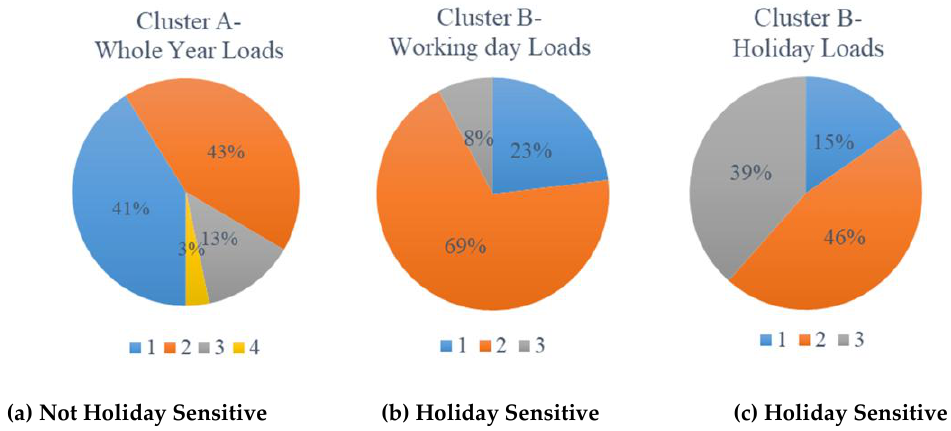
Figure 5. Distribution of numbers of clusters for two types of power usage patterns.